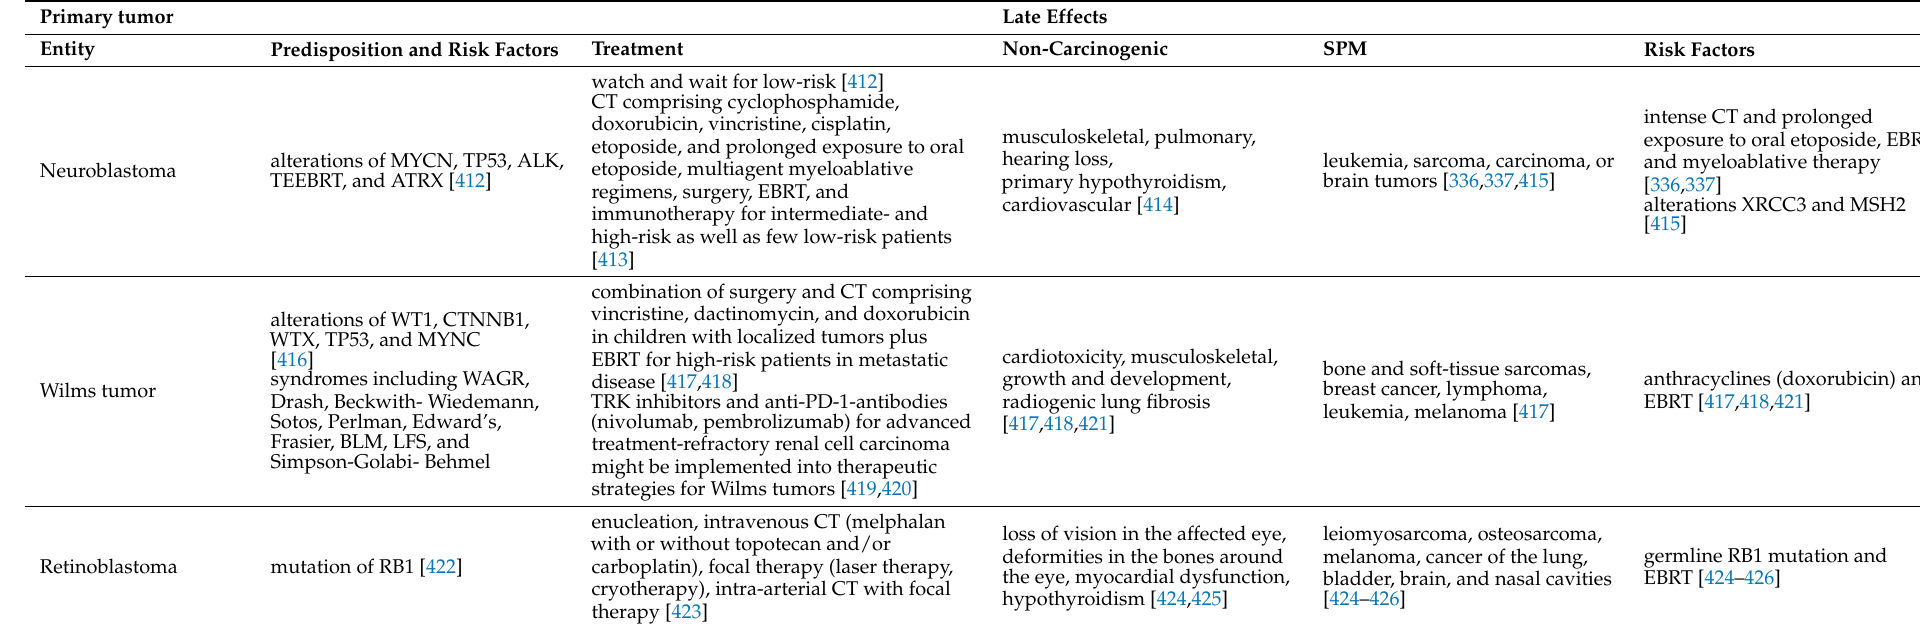
Table 4. Primary childhood neuroblastoma, Wilms tumor, and retinoblastoma, risk factors for their development, current treatments, non-cancerous late effects, most common second primary malignancies, and risk factors for their